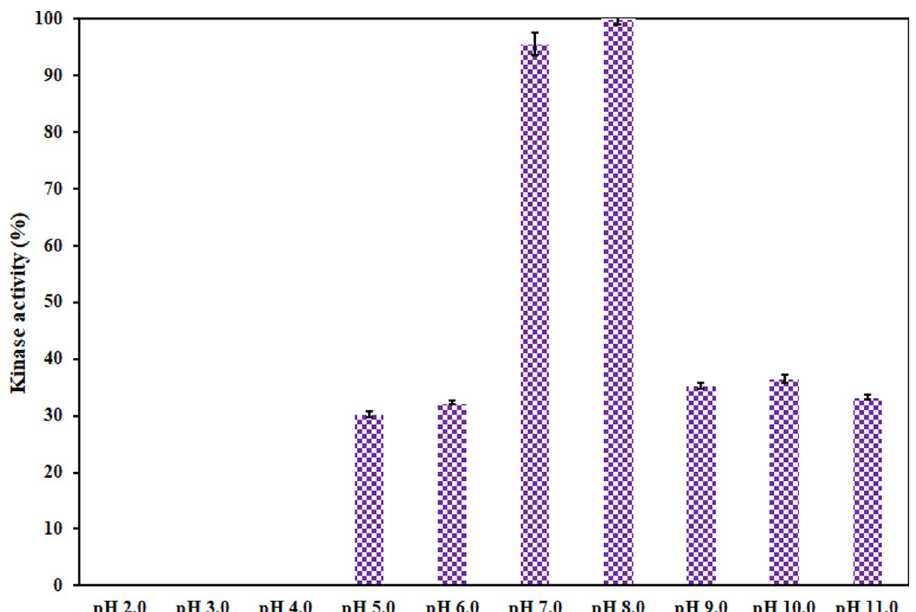
Fig 5. The kinase activity of CDK6 was plotted as a function of pH (2.0–11.0). The maximum activity of CDK6 was observed at pH 8.0, and it was arbitrarily set as 100% to normalize the data. Due to protein aggregation, the enzymatic activity was not determined in the pH range of